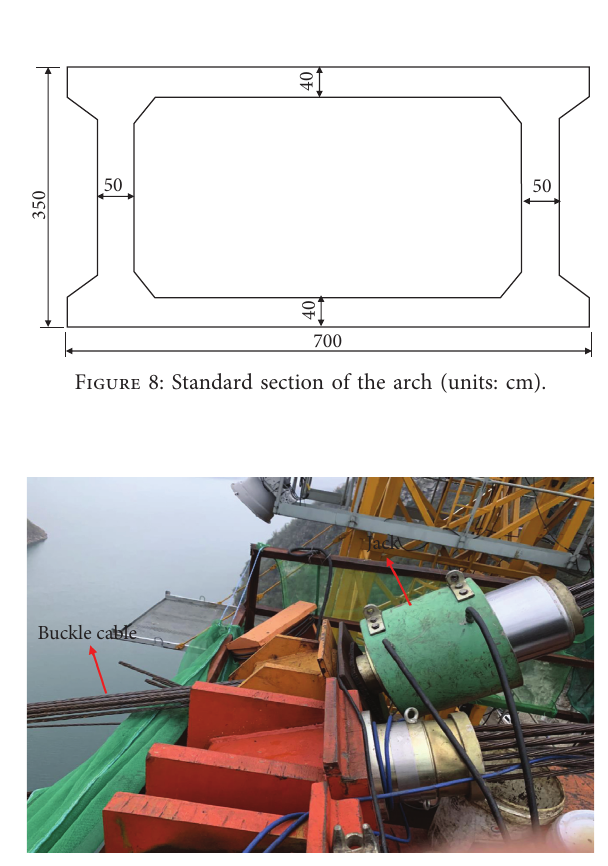
Figure 9: Tension arch ring segment i buckle cable and anchor